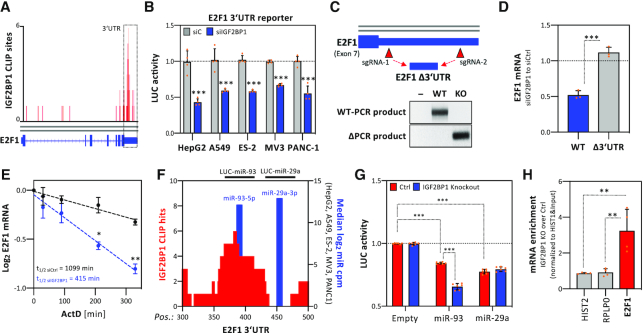
IGF2BP1 enhances E2F1 mRNA stability in a 3′UTR- and miRNA-dependent manner. (A) IGF2BP1 CLIP profile of the E2F1 mRNA. The 3′UTR is highlighted by dashed lines. (B) E2F1 3′UTR luciferase activity in indicated cancer cells upon control- or IGF2BP1-depletion. Reporter activities, normalized to a control reporter, were determined in four independent experiments. (C) Experimental strategy of the genomic deletion of the E2F1 3′UTR by the Cas9 nuclease using indicated CRISPR guide RNAs (sgRNAs) (Top panel). Representative PCR analysis on genomic DNA of parental PANC-1 (WT) and an E2F1 3′UTR-deleted PANC-1 cell clone (KO). (D) RT-q-PCR analysis of E2F1 mRNA levels upon IGF2BP1 depletion in parental PANC-1 (WT, blue) or the E2F1 3′UTR-deleted PANC-1 cell clone (Δ3′UTR, grey) normalized to control-transfected cells. RPLP0 served as internal normalization control. (E) E2F1 mRNA decay was monitored by RT-q-PCR in control- (black) or IGF2BP1-depleted (blue) PANC-1 cells upon indicated time of Actinomycin D (ActD) treatment. Error bars indicated standard deviation. Average mRNA half-life, determined in three independent studies, is indicated. (F) The graph depicts the number of CLIP studies showing overlapping IGF2BP1-CLIP sites (left axis, red; CLIP hits) and the position (x-axis) of miRNA targeting sites (blue) in the E2F1 3′UTR. MiRNA abundance (right axis, blue) is indicated as median log2 cpm determined by small RNA-seq of indicated cell lines. Luciferase reporter comprising indicated regions of the E2F1–3′UTR (LUC-miR-93, LUC-miR-29a) and analyzed in (G), are indicated in the top panel. (G) Luciferase reporter analysis demonstrating activity of indicated reporters in parental (Ctrl, red) or IGF2BP1-knockout (blue) A549 cells. Reporter activities, normalized to a control reporter without miRNA targeting site (Empty), were determined in three independent experiments with two technical replicates each. (H) Co-purification of mRNAs with AGO2 in parental (Ctrl) or IGF2BP1-knockout A549 cells was analyzed by immunoprecipitation using anti-AGO2 antibodies and RT-q-PCR analysis (right panel). HIST2 and RPLP0 served as negative controls. HIST1 served as normalization control. Statistical significance was determined by Student's t-test: *P <0.05; **P < 0.01; ***P < 0.001.